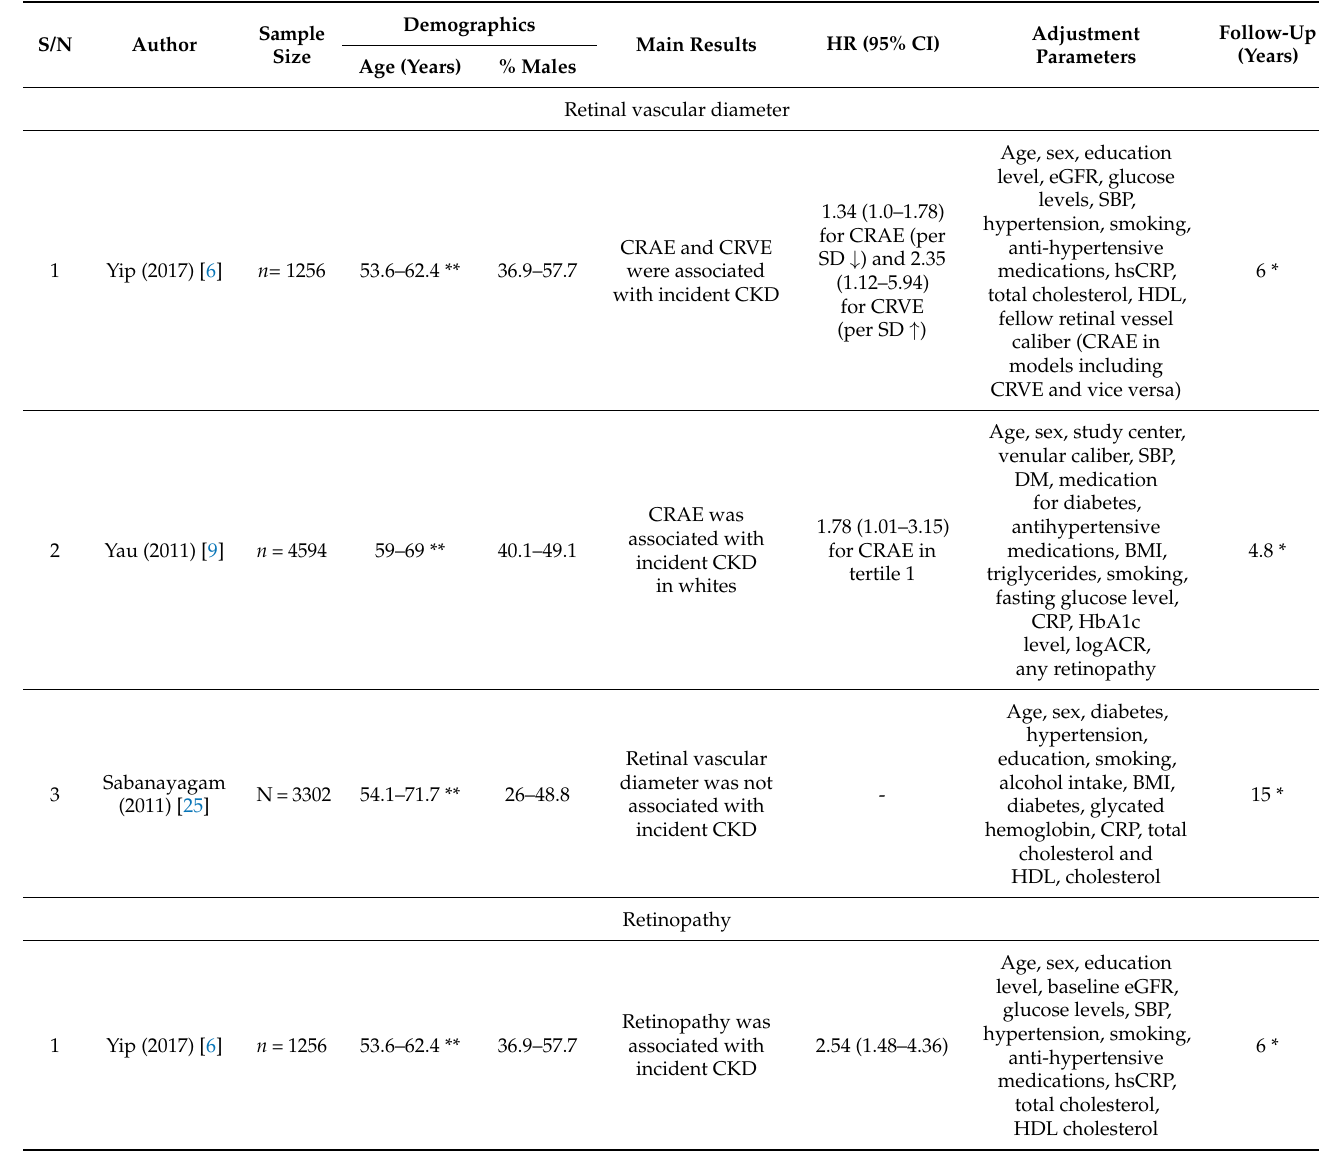
Table 1. Retinal microvascular and incident